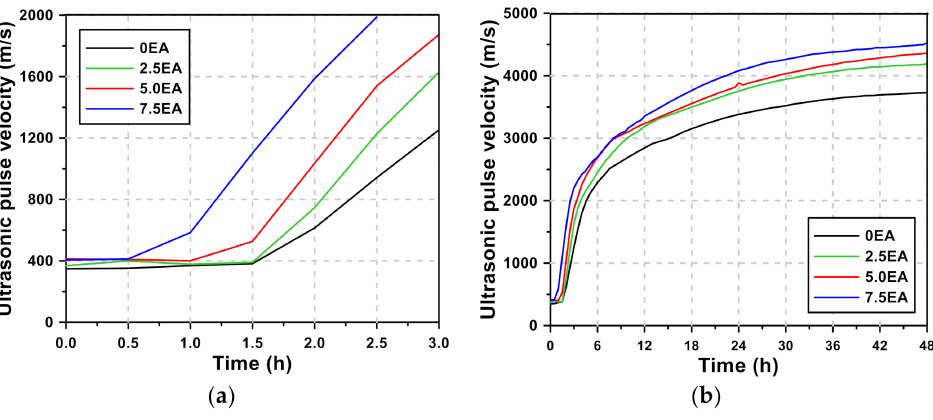
Figure 3. AAM mortar of ultrasonic pulse velocity curve: ( a ) Time: 3 h, ( b ) Time: 48